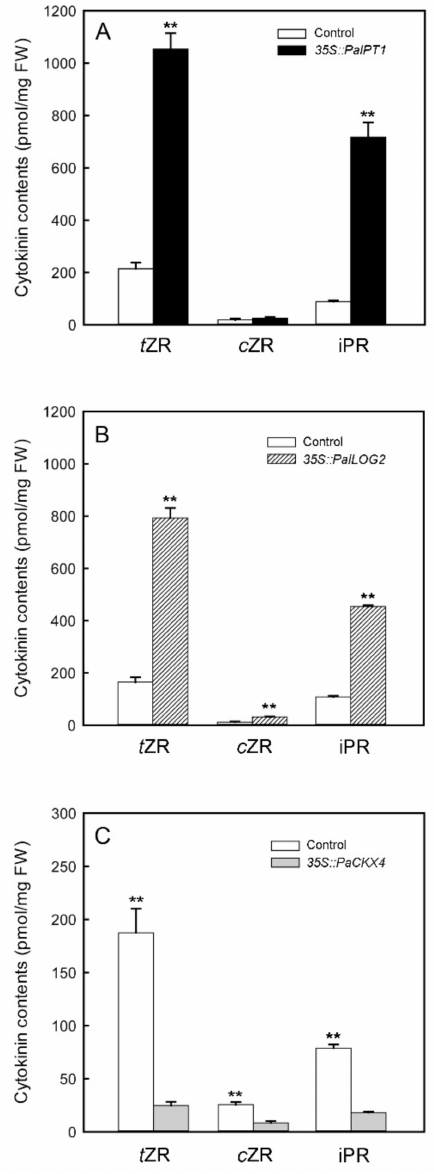
Figure 6. Levels of cytokinins in the PaIPT1 ( A ), PaLOG2 ( B ), and PaCKX4 ( C ) transiently overex- pressed tobacco leaves. The transiently overexpressed 35S::GFP tobacco leaves were used as their controls. Data are the mean of three biological replicates and error bars represent ± standard de- viations. Data were analyzed by unpaired Student’s t -test, and significant differences were set at p < 0.01